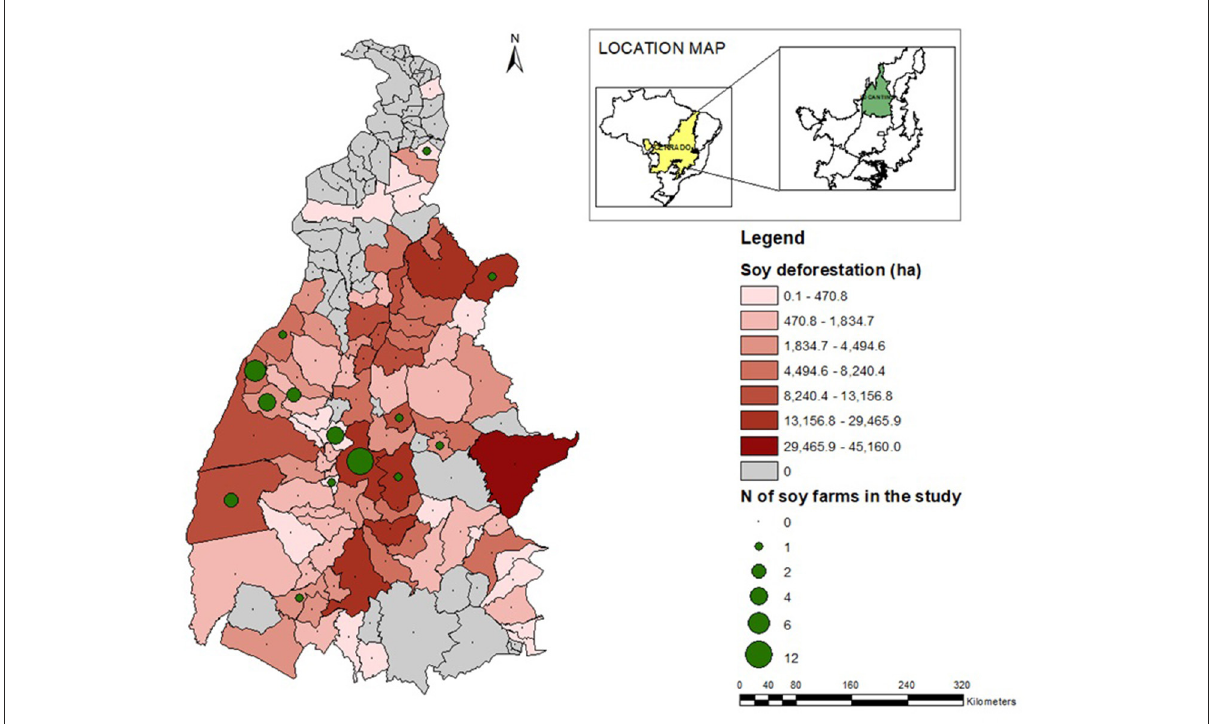
FIGURE4 Map of soy deforestation per municipality in Tocantins State between 2003 and 2018, with the respective numbers of soy farms belonging to the study participants. Soy deforestation data source: Trase